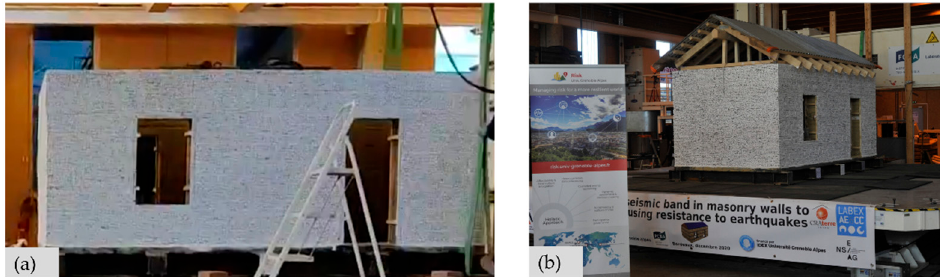
Figure 7. ( a ) Positioning of the metal frame to fix it to the shake table; ( b ) roof installation on the building.